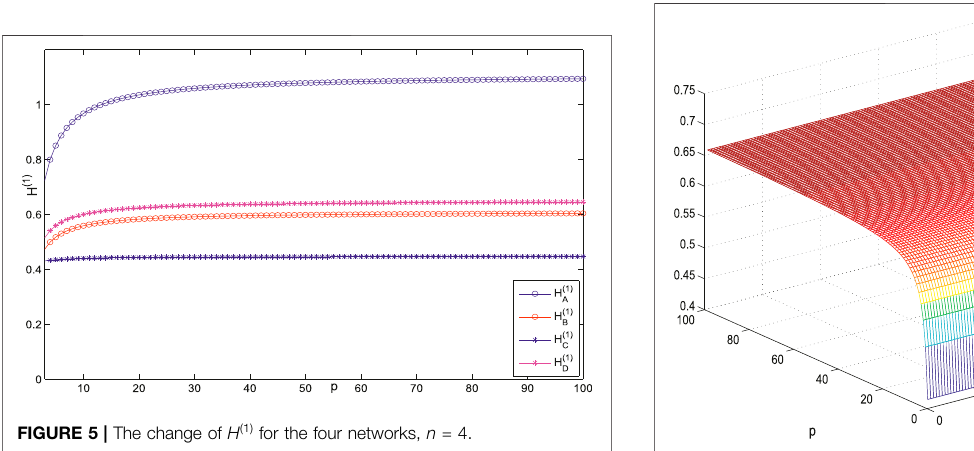
FIGURE 5 | The change of H (1) for the four networks, n (cid:1) 4.